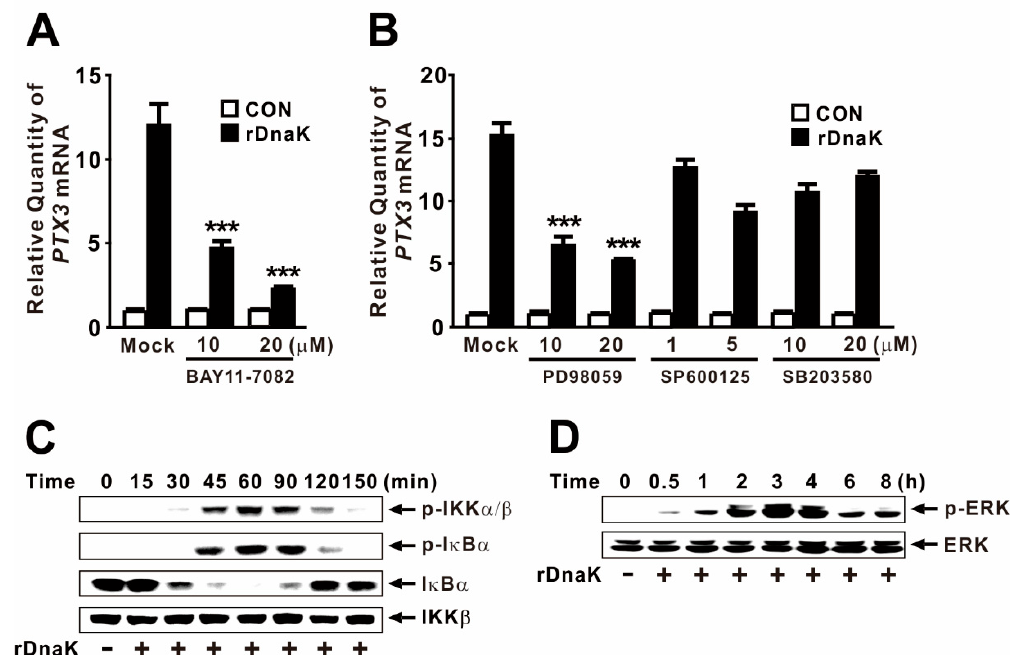
Figure 2. DnaK-induced production of PTX3 is mediated by the NF- κ B and ERK signaling pathways . ( A , B ) The dTHP-1 cells were pretreated with the indicated concentrations of chemical inhibitors for 1 h followed by treatment with 1 μ g/mL rDnaK for 4 h. ( C , D ) The dTHP-1 cells were treated with 1 μ g/mL rDnaK for the indicated time. After treatment, qRT-PCR and immunoblot analyses were performed. Data in A , B are expressed as means ± SD ( n = 3). Data in C , D are representative of three separate experiments. *** p < 0.001 vs. rDnaK treatment in the absence of inhibitors ( A , B ).